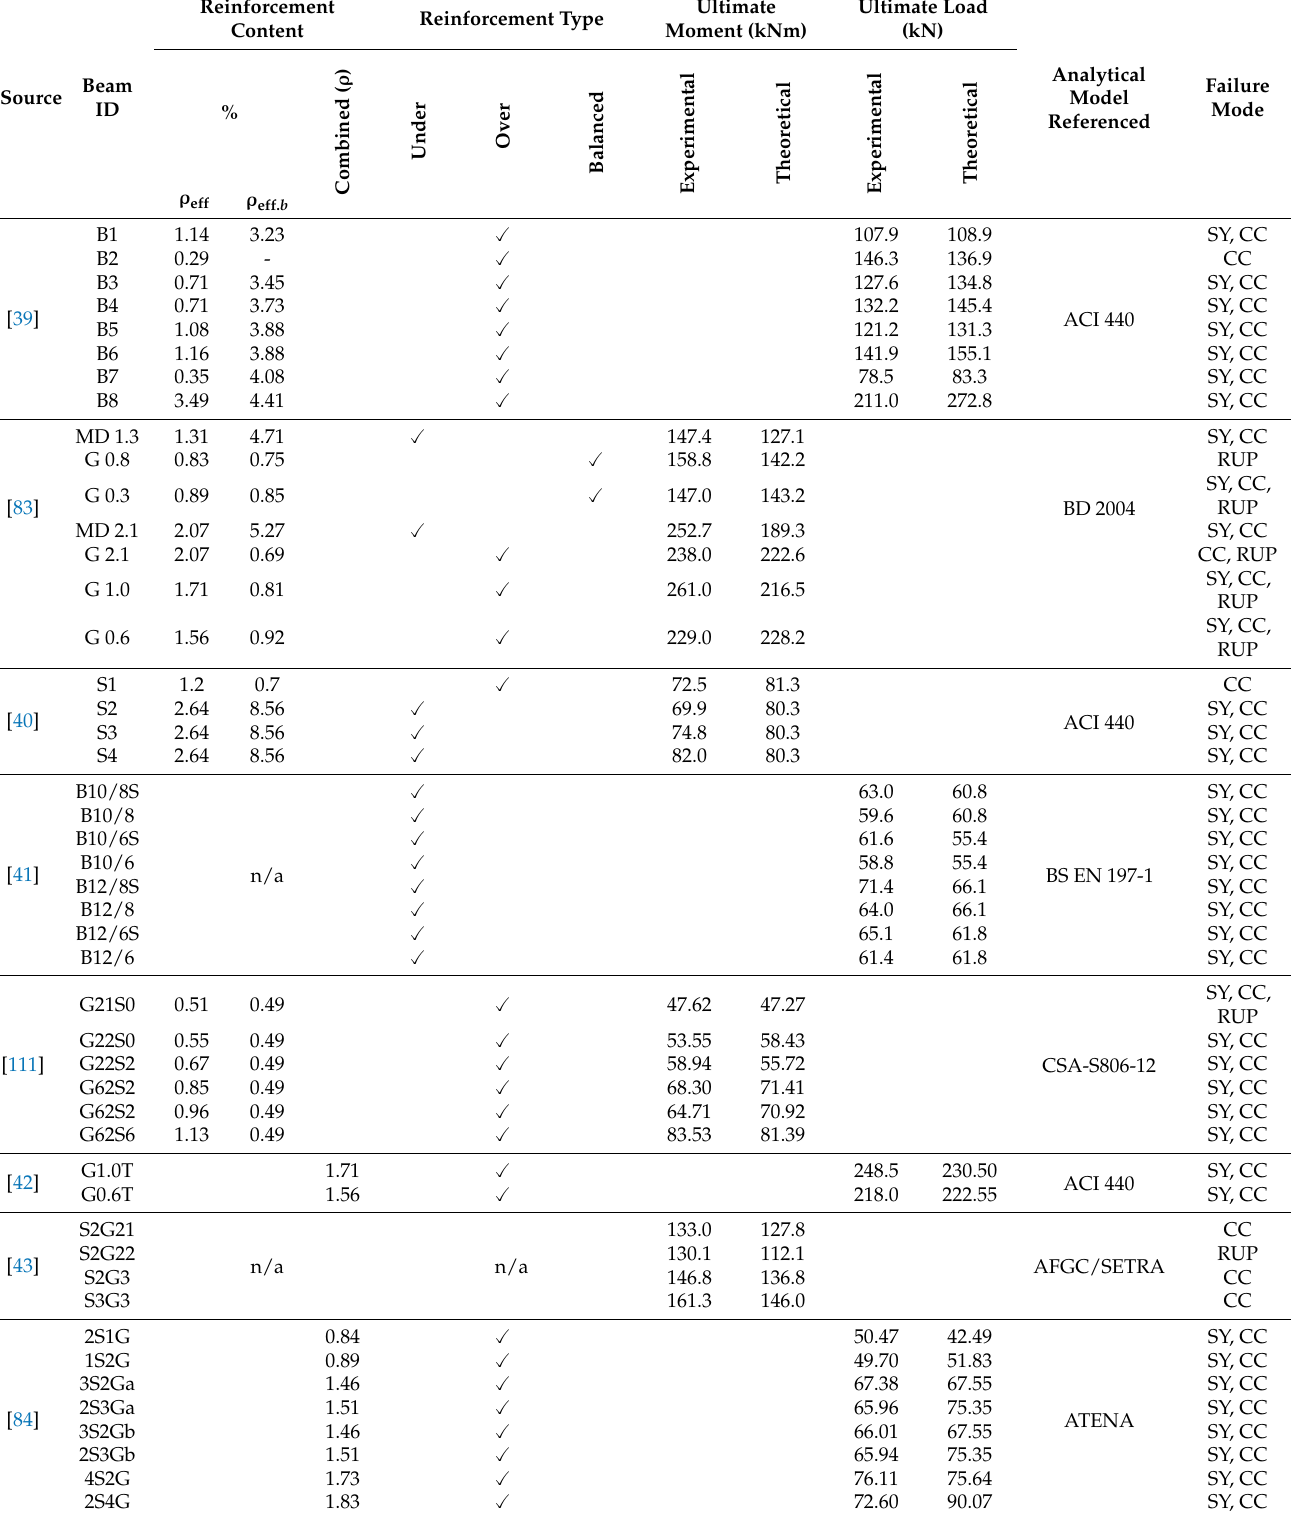
Table 2. Overview of Tested